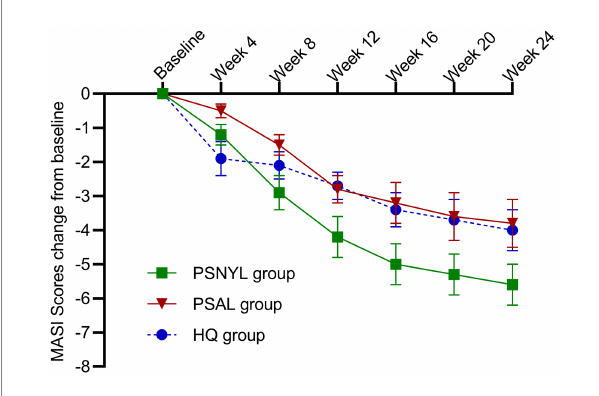
FIGURE 3 Change in MASI scores from baseline in the three groups. PSNYL, picosecond Nd:YAG laser (1,064 nm); PSAL, picosecond alexandrite laser (755 nm); HQ, hydroquinone